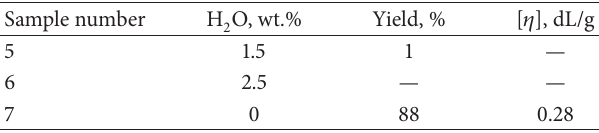
Table 4: EMROP of pentadecalactone. Dependence of reaction time, yield, and intrinsic viscosity of resulting products on reaction temperature.